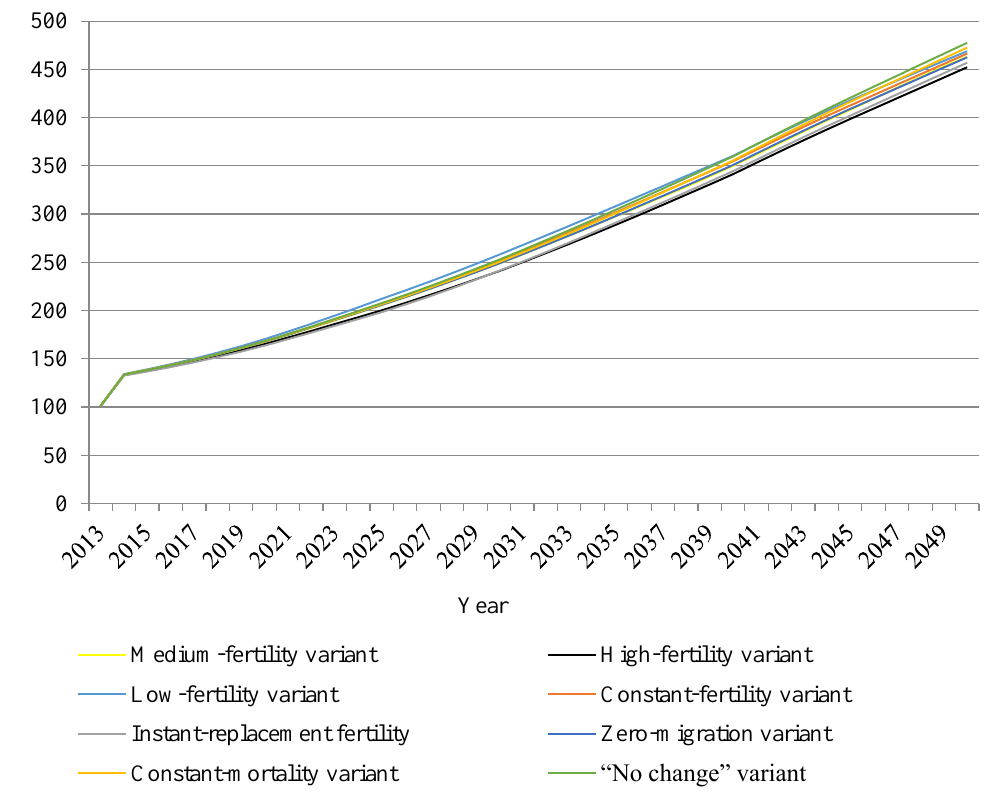
Figure 16. Sensitivity analyses under varying Chinese population growth